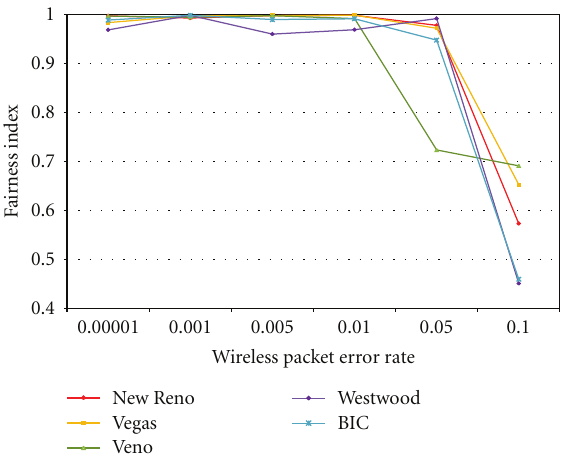
Figure 13: Fairness for various DL:UL ratios (PER = 10 − 5 ). Table 2: IEEE 802.11b simulation